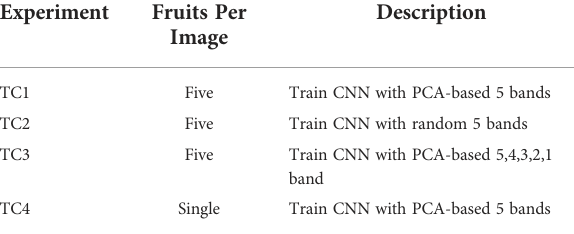
TABLE 2 Description of four types of experiments that were conducted in the